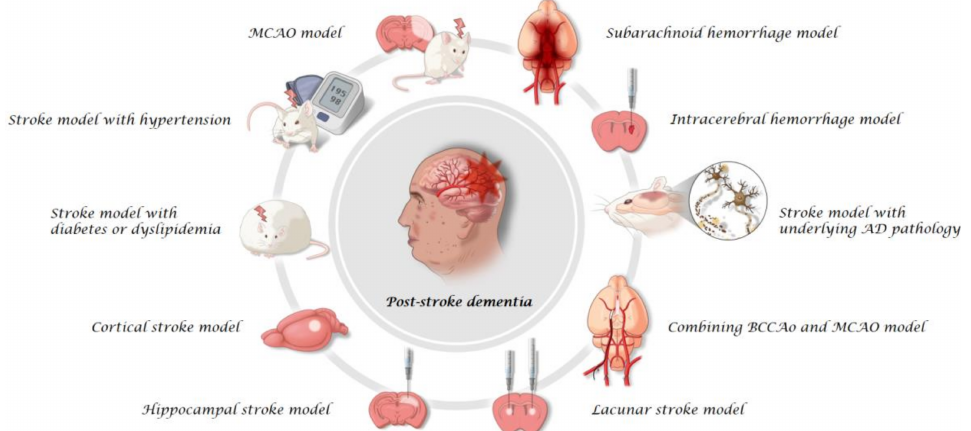
Figure 1. Diverse rodent animal models of post-stroke dementia. (Middle cerebral artery occlusion, MCAO; bilateral common carotid artery occlusion, BCCAo; Alzheimer’s disease,